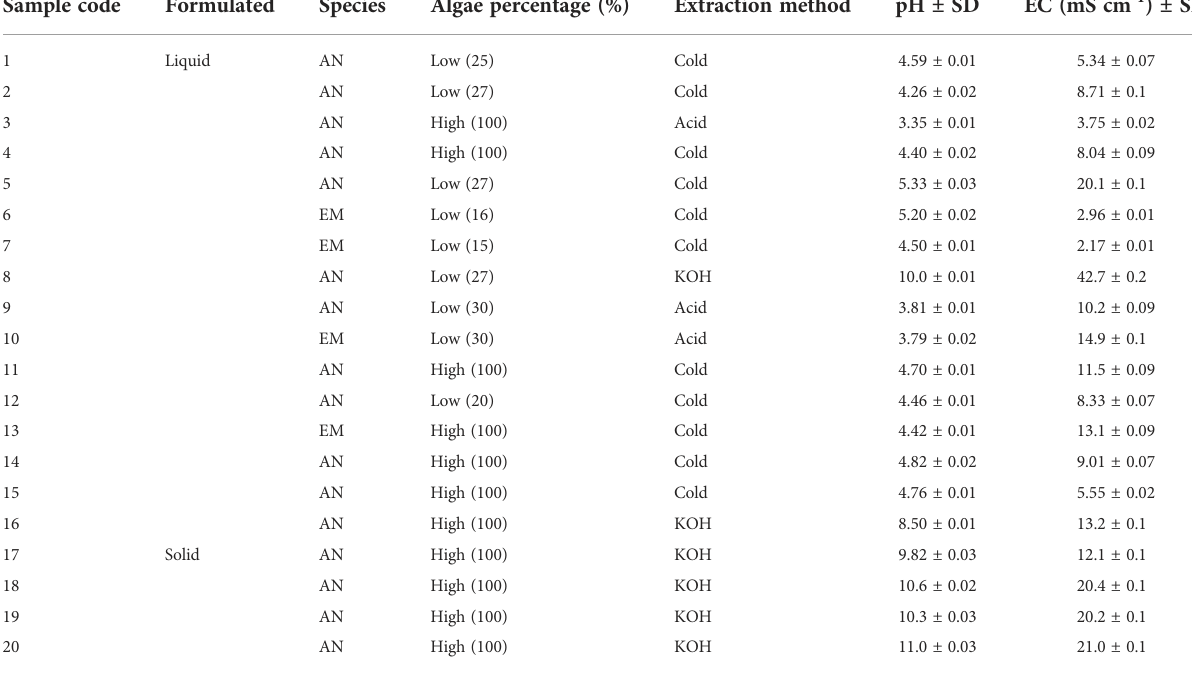
TABLE 1 Description of the seaweed products selected for this study according to criteria described in Section 2.1